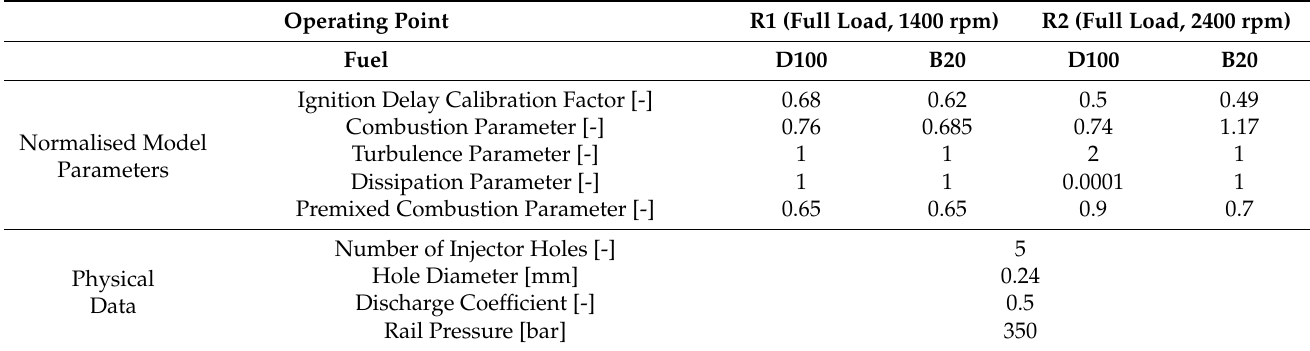
Table 4. The values adopted for the normalized parameters and physical properties of the AVL MCC.